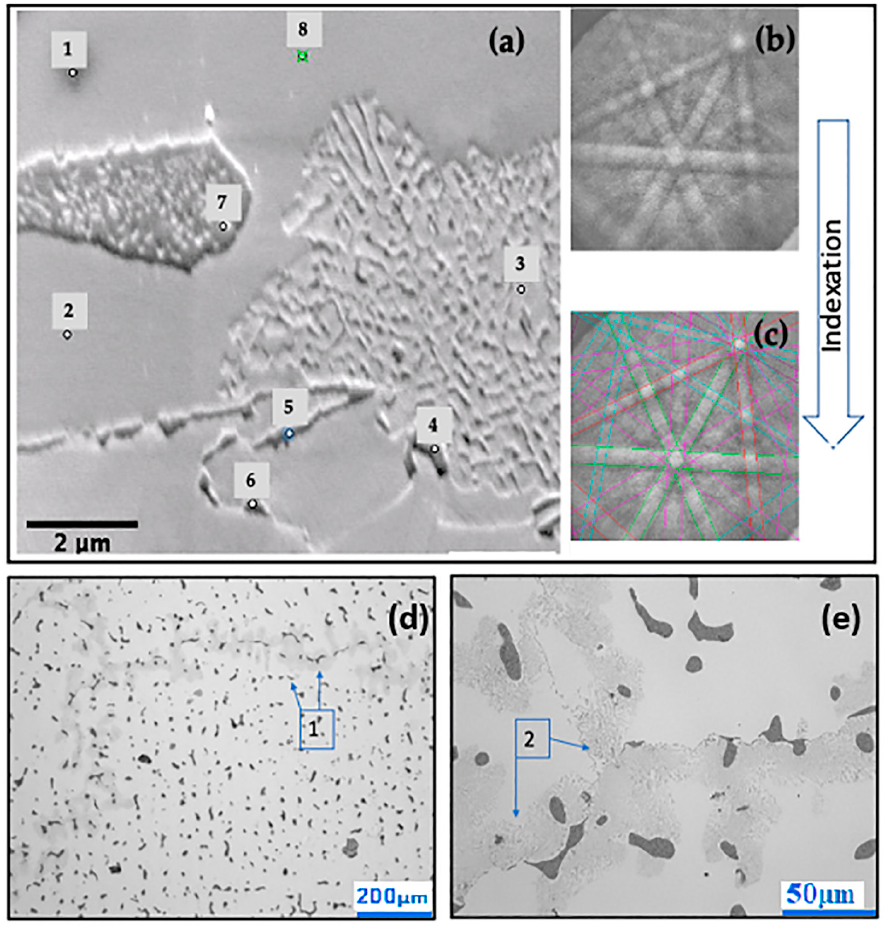
Figure 8. ( a ) SEM image showing the 8 points evaluated. ( b ) Kikuchi lines and the diffraction pattern. ( c ) Marking of higher lines. ( d ) Grain boundaries, identified as M 23 C 6 . ( e ) Lamellar constituent.